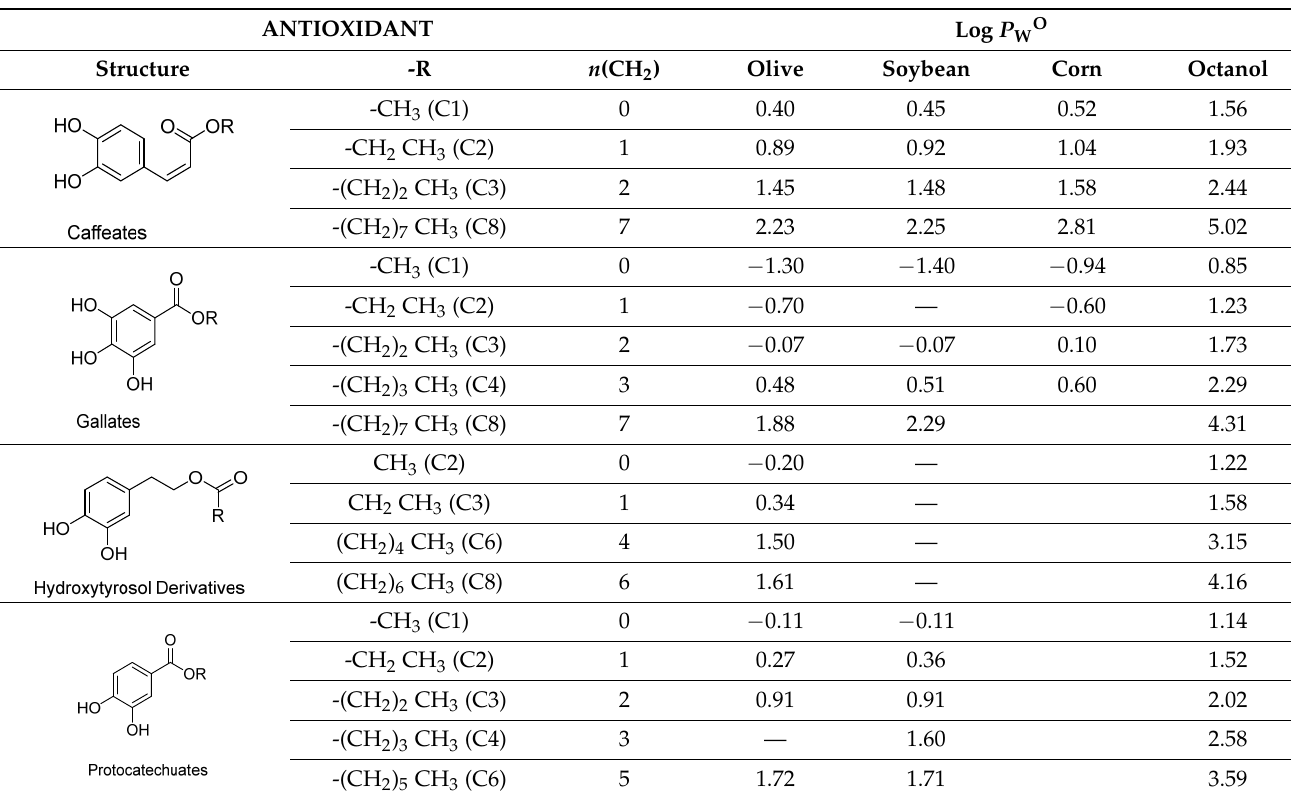
Table 4. Experimental partition constants for the distributions of AOs of different hydrophobicities in oil–water systems and theoretical octanol–water values, T = 25 ◦ C. Data extracted from Freir í a- G á ndara et al.